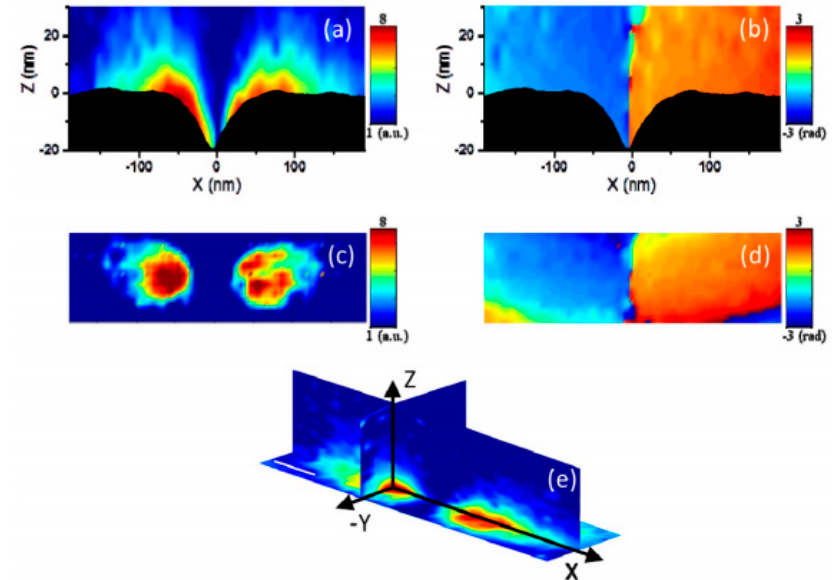
Figure 11. 3D SNOM amplitude and phase images of a bowtie antenna. The amplitude ( a ) and phase ( b ) images in an x - z plane showing a cross-section of the bowtie aperture. Panels ( c ) and ( d ) are 2D amplitude and phase images, respectively, sized 400 nm × 100 nm and taken at the bowtie antenna surface, z = 0; ( e ) Combined scans showing the 3D light field of the antenna where the white scale bar represents 50 nm. Reproduced with permission from [50], Copyright Optics Express, 2015.